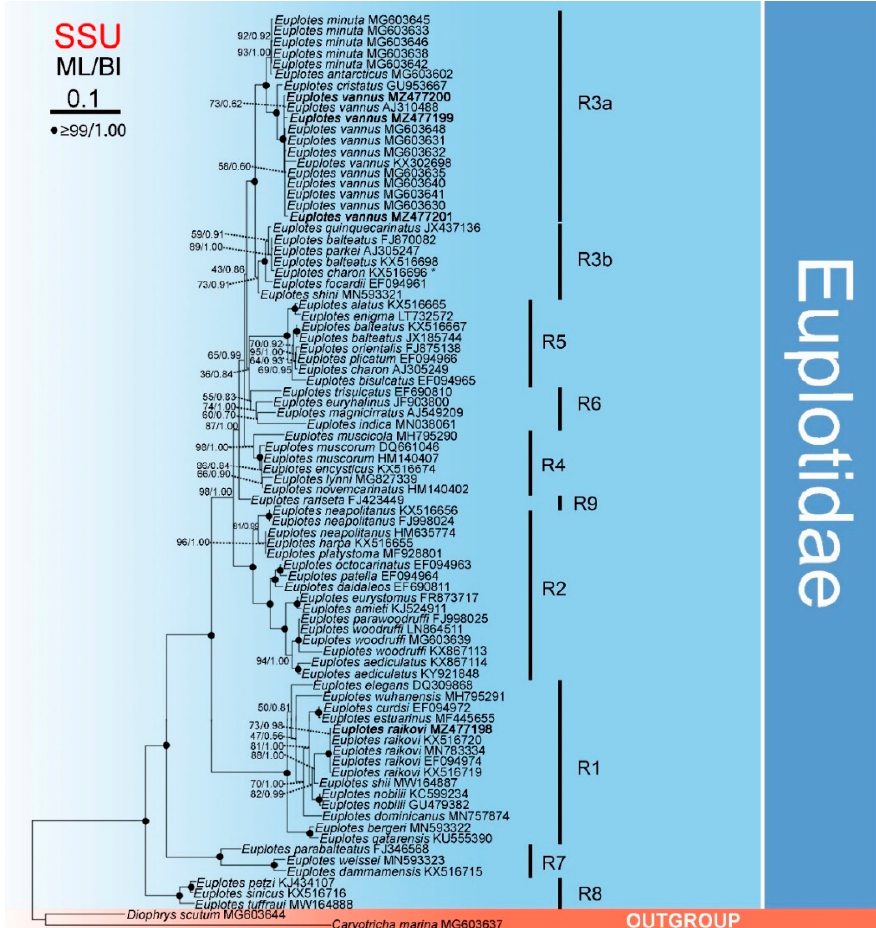
Figure 2. Maximum likelihood (ML) tree inferred from SSU rDNA sequences showing nodal support for ML and BI analyses. Newly sequenced species are shown in bold. A hyphen ( − ) reflects disagreement in topology between the BI and ML trees. R1–9 represent different clades. The scale bar corresponds to 10 substitutions per 100 nucleotide positions. * misidentification, should be Euplotes balteatus .